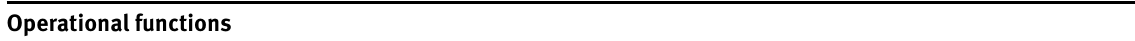
Table 2: Main functions associated with the maintenance of